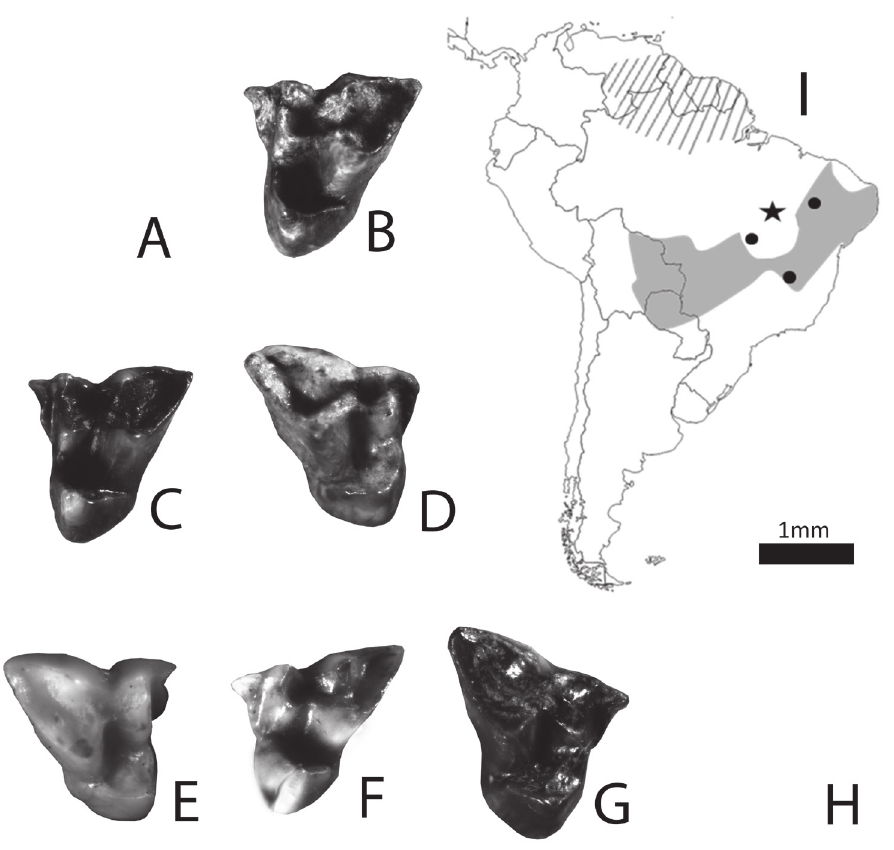
Figure 5 - Selected specimens of Monodelphis from Gruta dos Moura and its revised geographic distribution for the Pleistocene. A. Monodelphis brevicaudata left M2 (UNIRIO-PM1099) in occlusal view; B. M. brevicaudata left M1 (UNIRIO-PM1097) in occlusal view; C. M. brevicaudata left M2 (UNIRIO-PM1230) in occlusal view; D. M. brevicaudata right M1 (UNIRIO-PM1098) in occlusal view; E. Monodelphis domestica right M3 (UNIRIO-PM1233) in occlusal view; F. M. domestica left M1 (UNIRIO-PM1102) in occlusal view; G. M. domestica right M1 (UNIRIO- PM1101) in occlusal; H. M. domestica right M1 (UNIRIO-PM1110) in occlusal view. Scale 1mm. I. Geographic distribution of M. brevicaudata and M. domestica . Gray area is the geographic distribution of the extant M. domestica . Area with vertical lines is the geographic distribution of the extant M. brevicaudata. Black star marks the Gruta dos Moura cave locality. Black circles